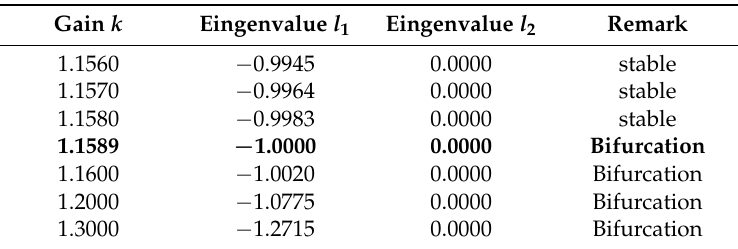
Table 1. Characteristic multipliers of the boost converter for increasing values of the gain k . The bold value in the first column denotes the threshold when bifurcation occurs.